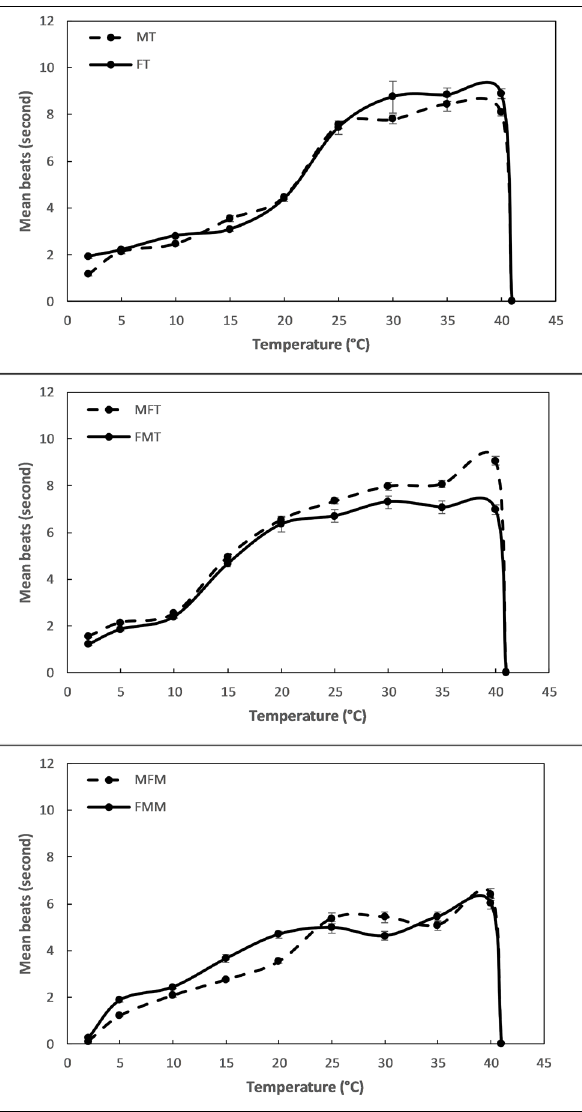
Figure 1. Compression of limb beating rate of male and female Branchipus schaefferi under different culture treatments. (MT: males in tap water; FT: females in tap water; MFT males in the presence of females in tap water, FMT: females in the presence of males in tap water; MFM: males in female culture medium; FMM: females in male culture